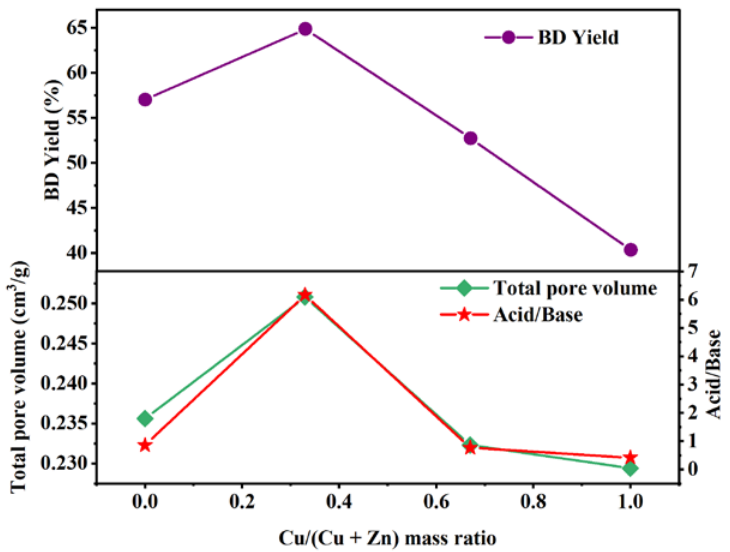
Figure 7. Correlations of pore volume and acid/base ratio with BD yield in all catalysts (acid/base is medium acid sites/weak plus strong base sites ratio).